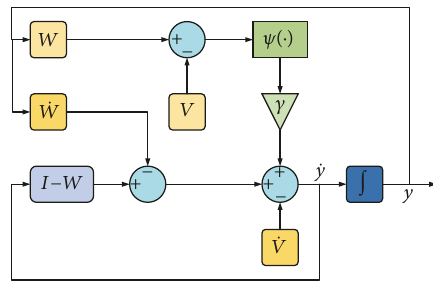
Figure 3: Diagram procedure of the TTZNN model